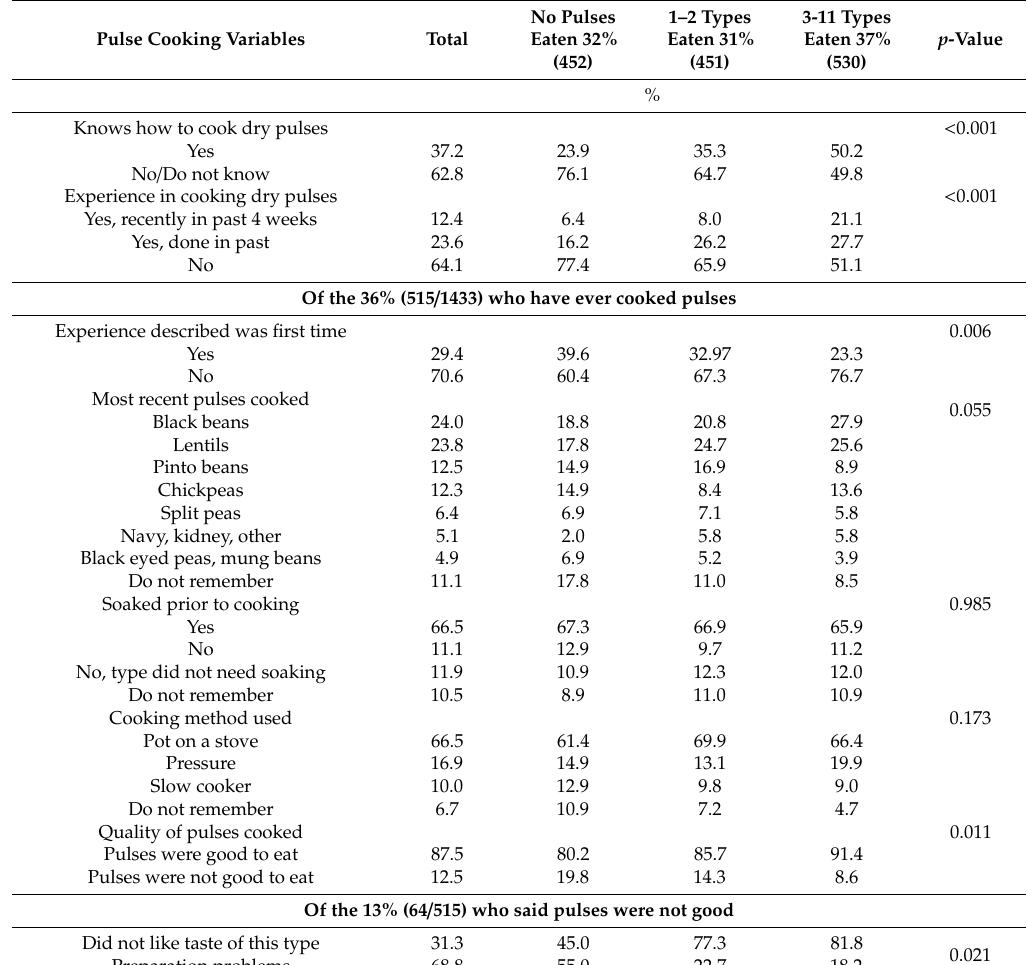
Table 4. Pulse-cooking experiences of students enrolled at a Midwestern US university by trivariate pulse type count eaten per month (%; n =